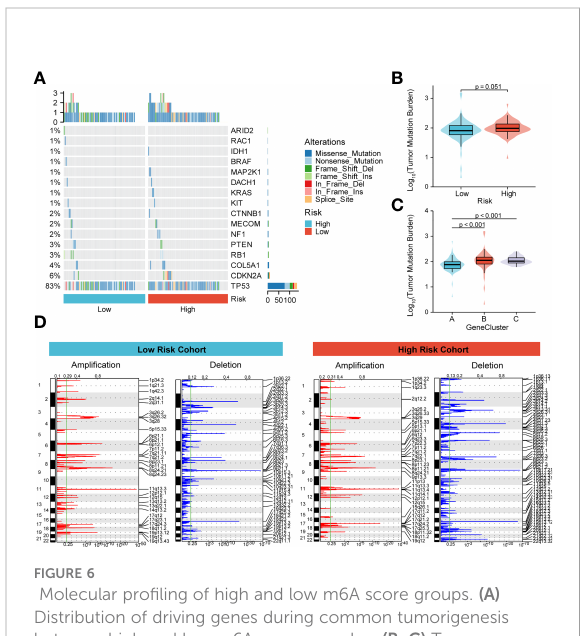
FIGURE 5 Genetic signature of risk grouping. (A) Relationship between GeneCluster groups, m6A signature groups, m6A risk scores, and clinical prognosis. (B) Kaplan – Meier curves indicate that there is a strong relationship between GeneClusters A, B, and C and the overall survival rate.